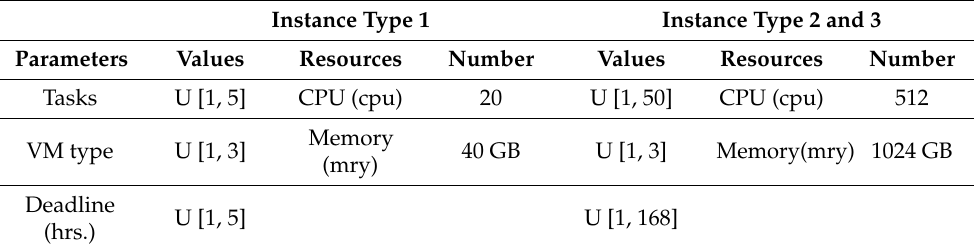
Table 5. Details of the